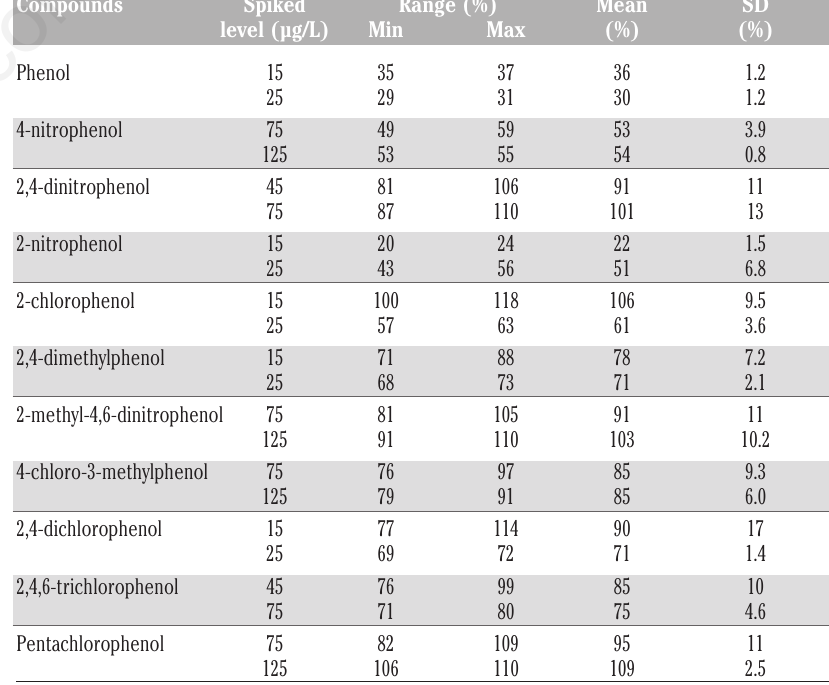
Table 5. Determination of the method accuracy as recovery (%) of phenolic compounds from wastewater spiked with different levels of standard concentration (n=3).